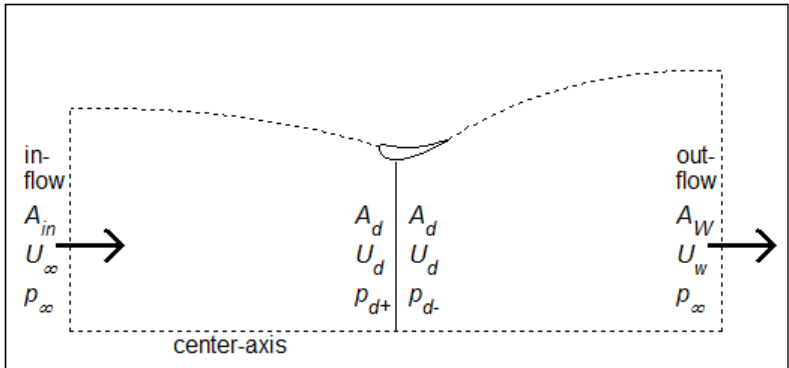
Figure 1. DAWT control volume. The captured mass-flow is marked by the streamline upstream of the diffuser airfoil. The wake is marked by the streamline downstream. Inflow is assumed far upstream, and outflow is assumed far downstream in the fully developed